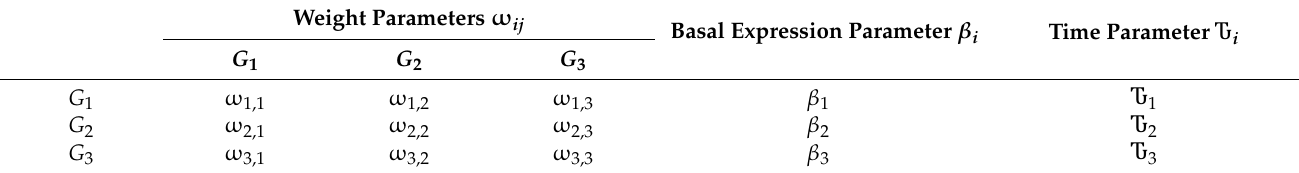
Table 1. Parameter set of random synthetic networks.